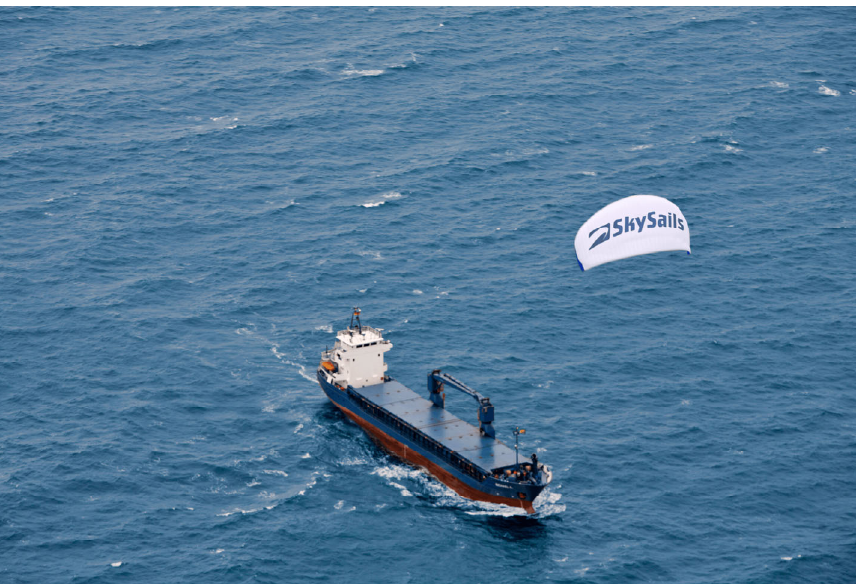
Figure 9. Photograph of the MS Michael A. in action with a kite sail. (Copyright SkySails Group GmbH).